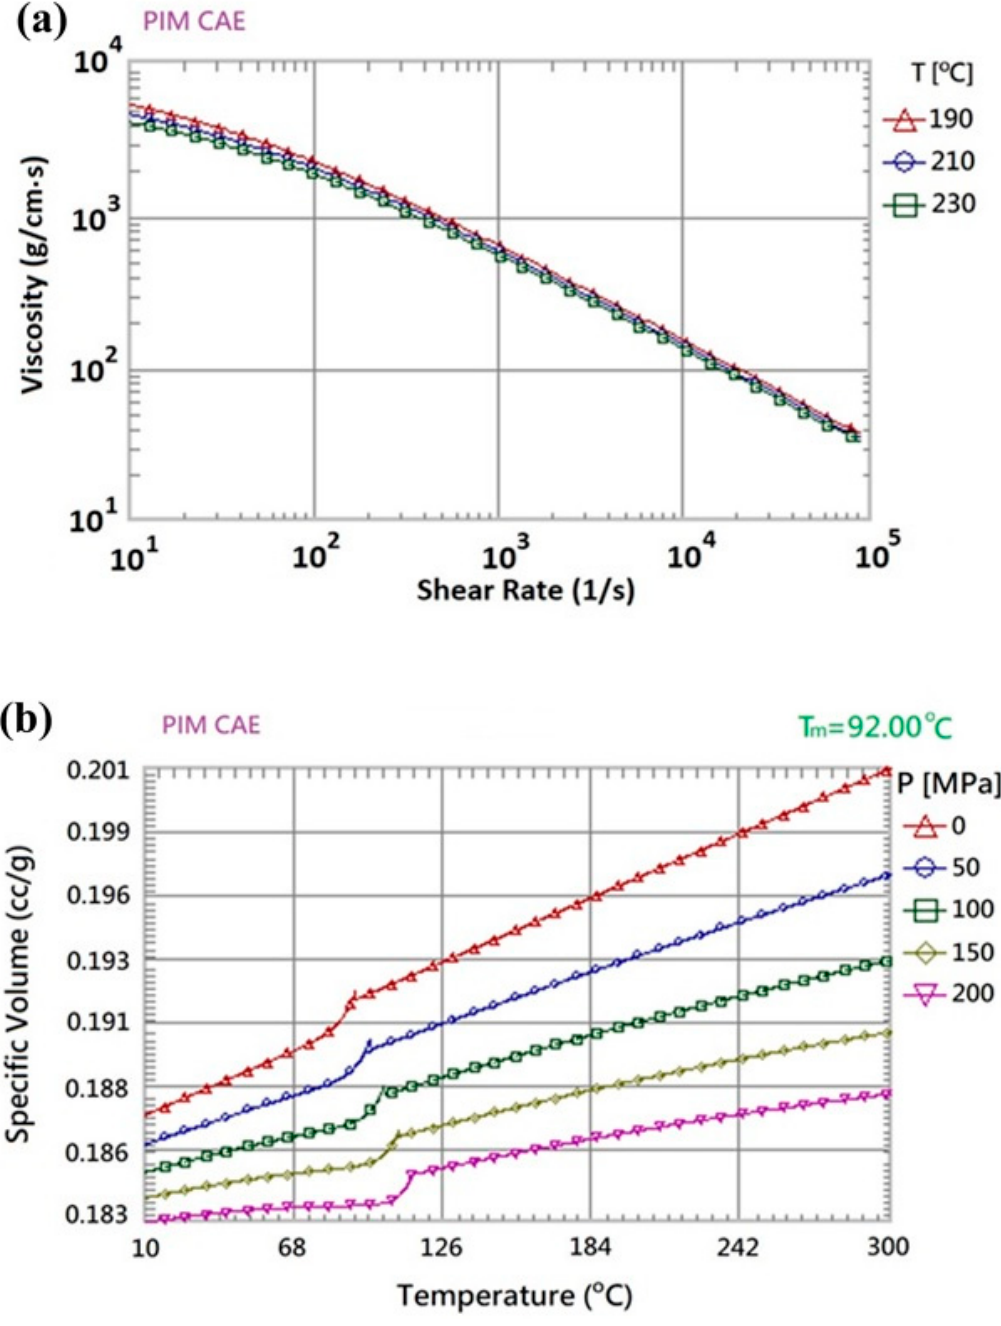
Figure 4. Material properties of composite material: ( a ) viscosity vs. shear rate and ( b ) specific volume vs. temperature.